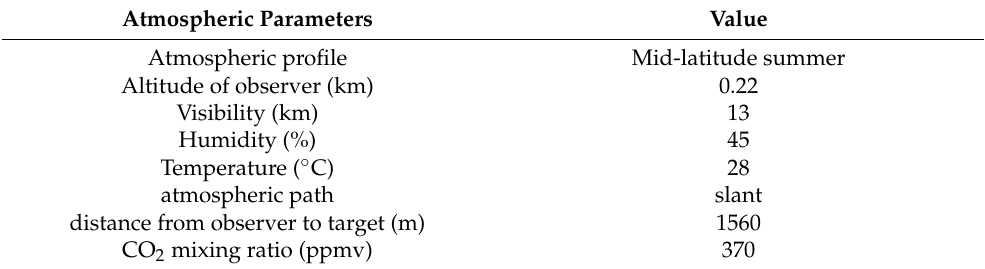
Table 7. Atmospheric parameters used in MODTRAN for the fan-shaped target test.